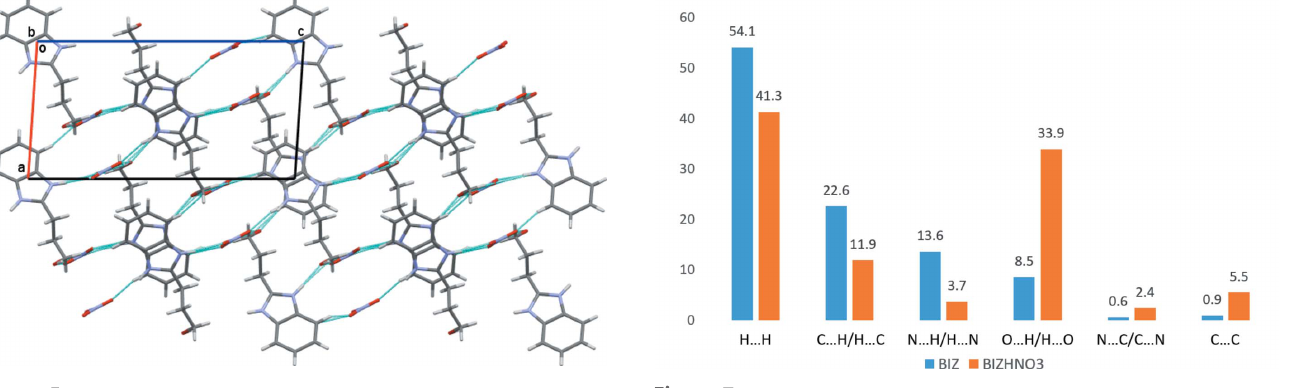
Figure 5 Crystal packing of the 2-(3-hydroxypropyl)benzimidazole nitrate salt in the BIZHNO3 structure. Projection in the [010] direction. Hydrogen bonds are shown by cyan